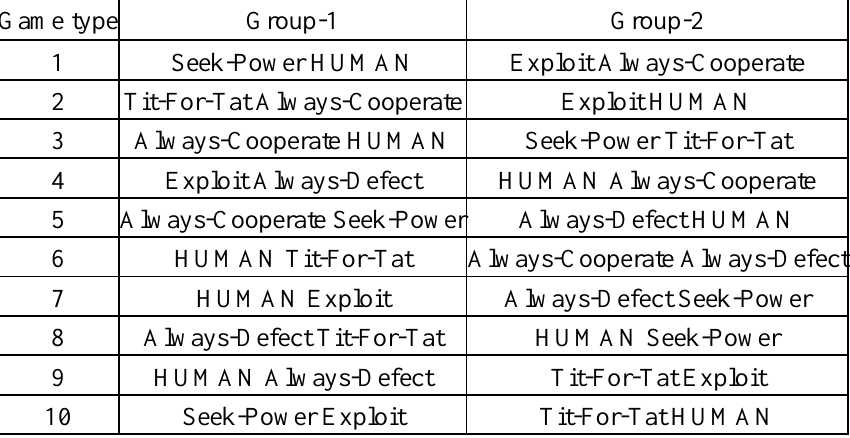
Table 3. The ten game types that resulted from matching the human participant with computer strategies. The numbers do not reflect any